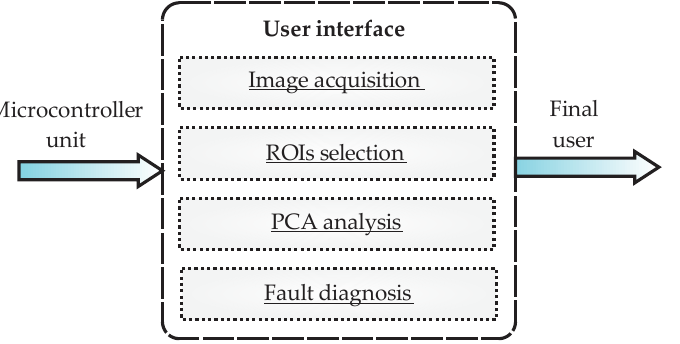
Figure 10. Block diagram of user interface in the smart sensor.